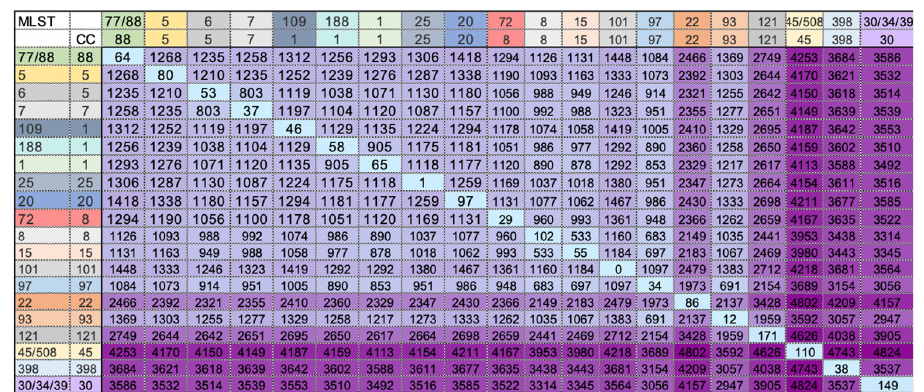
Fig 2. Heat map of median pairwise SNP distances between major